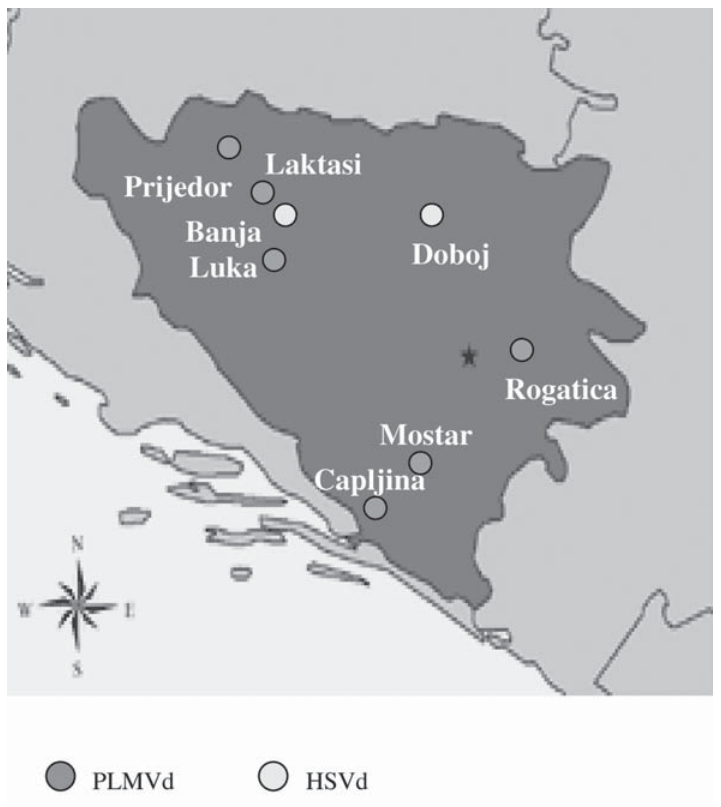
Fig. 2. Distribution (in circles) of PLMVd (solid) and HSVd (open) in Bosnia and